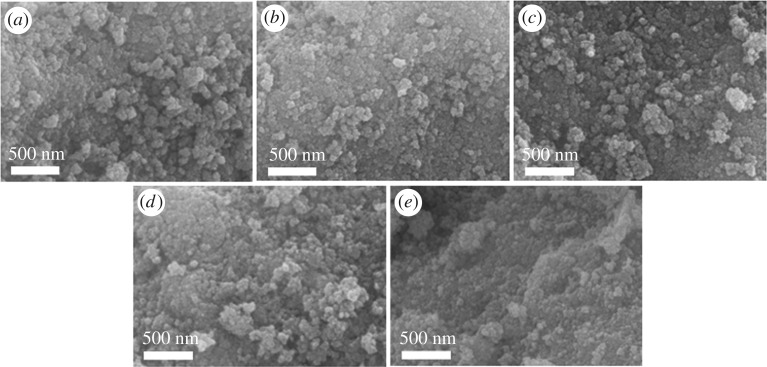
SEM images of all samples: (a) TiO2, (b) 0.5SO42−/TiO2, (c) 1.0SO42−/TiO2, (d) 1.5SO42−/TiO2, (e) 2.0SO42−/TiO2.